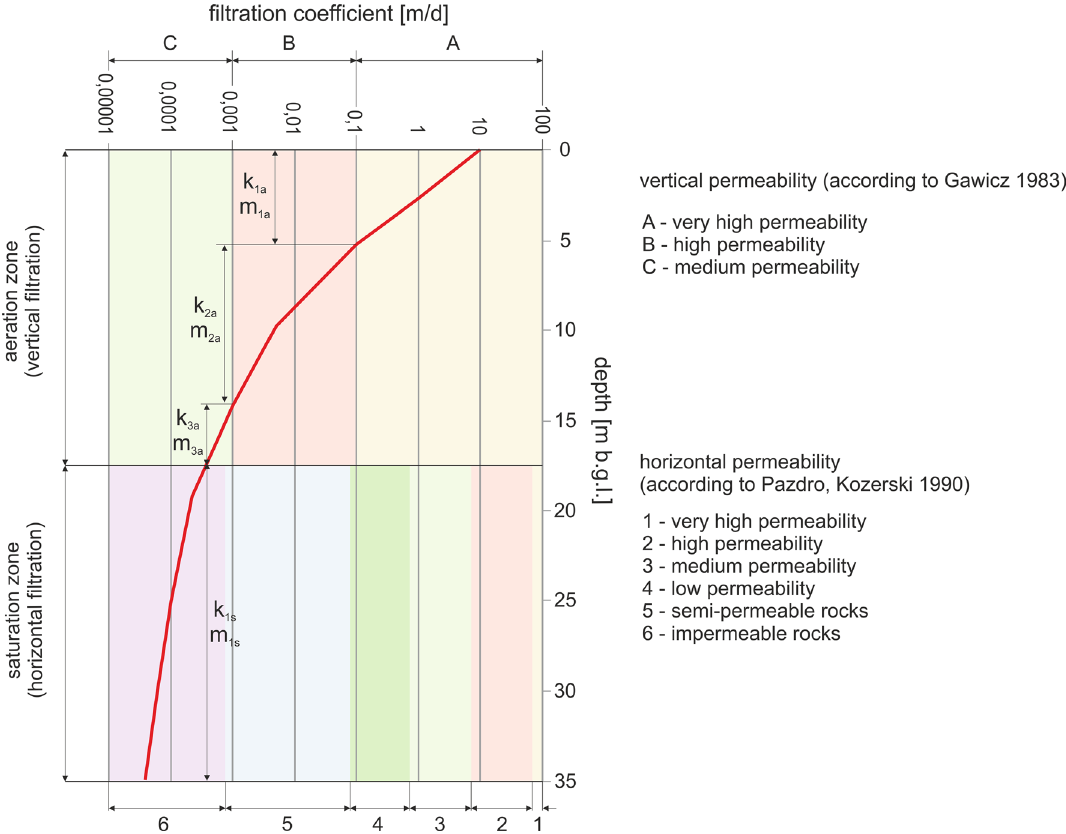
Fig. 5 Graph of changes in the value of the filtration coefficient for the longest deposited waste on the dumping ground as a function of